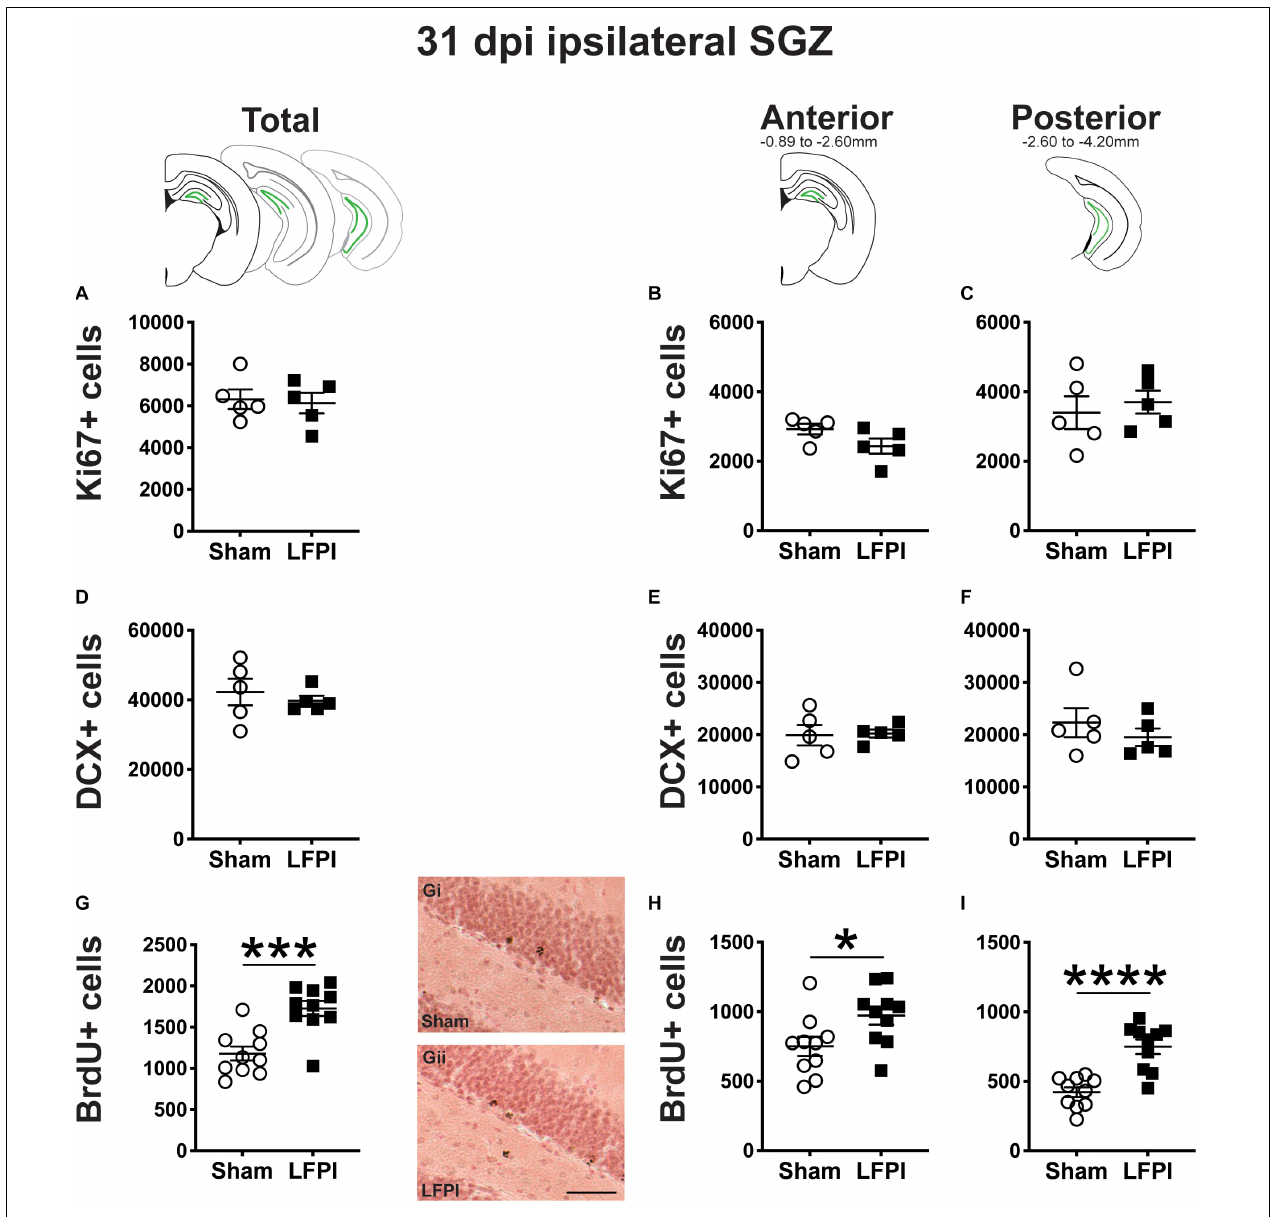
FIGURE 6 | Relative to Sham, LFPI increases the number of BrdU+ surviving cells in the ipsilateral mouse SGZ 31 dpi. Green lines in schematics (top row) indicate these measures were taken in the ipsilateral SGZ/GCL. Stereological quantification of Ki67+ ( A–C ; Sham n = 5, LFPI n = 5), DCX+ ( D–F ; Sham n = 5, LFPI n = 5), and BrdU+ ( G–I ; Sham n = 10, LFPI n = 10) cells in the SGZ (Ki67, BrdU) and GCL (DCX). Immunopositive cells were quantified across the entire longitudinal axis (A,D,G) , and also broken up into anterior (B,E,H) and posterior (C,F,I) bins, operationally defined as Bregma levels − 0.92 to − 2.6; and − 2.6 to − 3.97, respectively. Representative photomicrographs of Sham (Gi) and LFPI (Gii) BrdU-stained tissue are shown alongside quantification of total BrdU+ cells. Scale bar = 50 µ m. T-test, * p < 0.05, *** p < 0.001, and **** p < 0.0001.